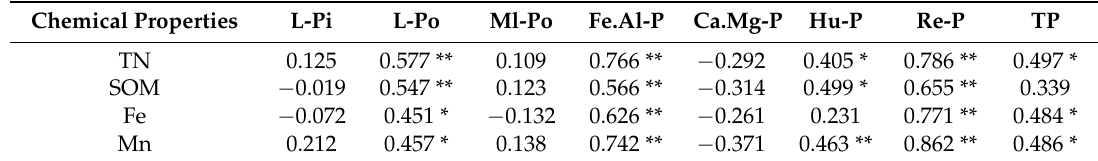
Table 3. Correlation analysis results between phosphorus fractions and soil chemical